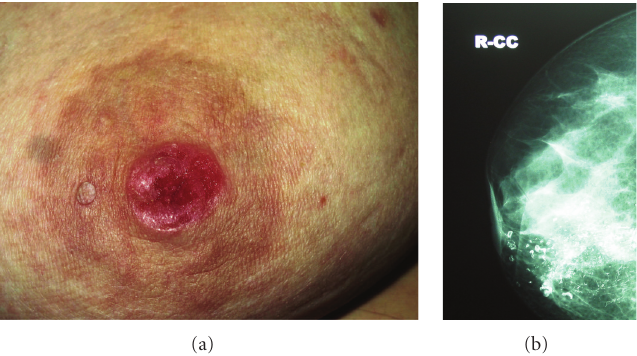
Figure 2: (a) An ulcerated lesion on the right nipple. (b) Pleomorphic and linear microcalcifications on the